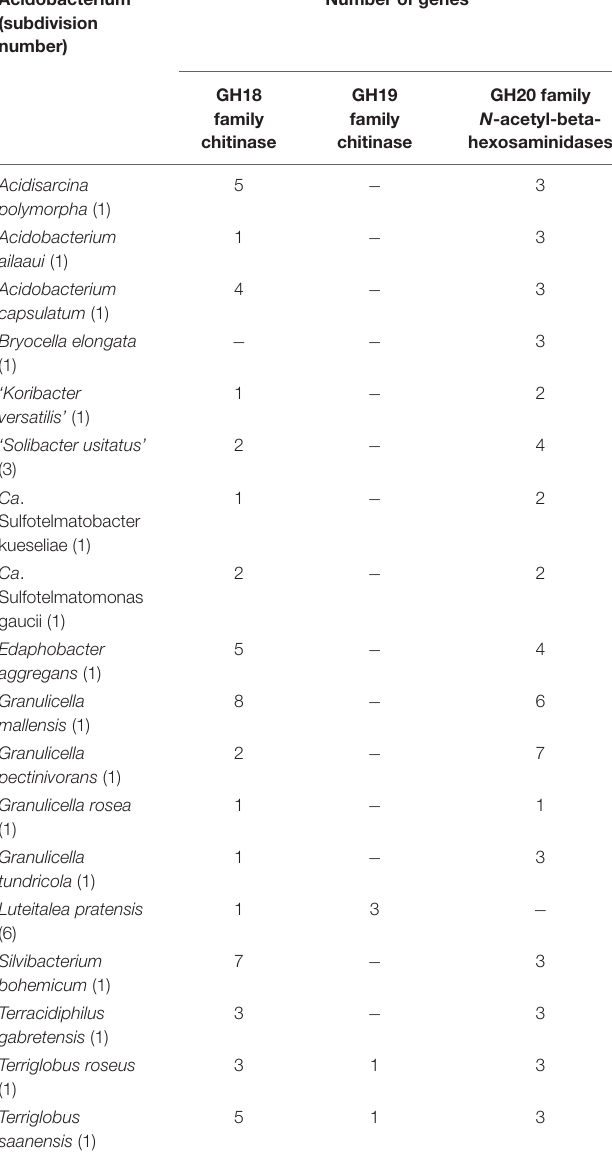
TABLE 6 | The presence of chitinases and N -acetyl-beta-hexosaminidases in